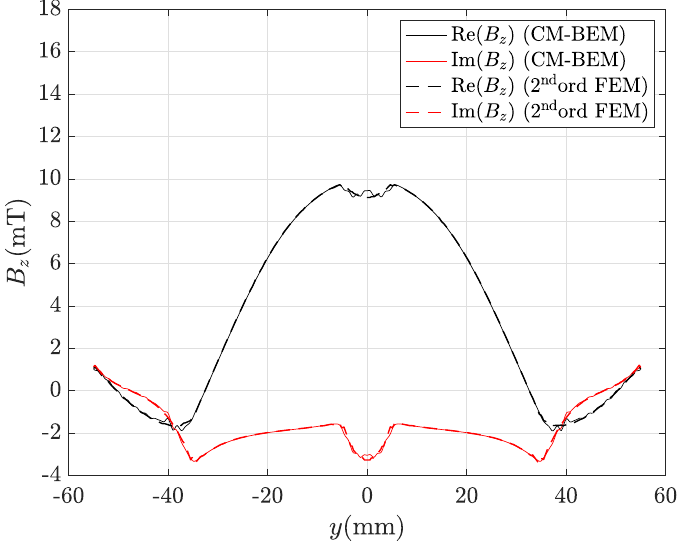
Figure 16. Real and imaginary parts of the z -axis magnetic flux density component at 200 Hz along the line A-B (CM–BEM plot is in straight line, FEM plot is in dashed line).